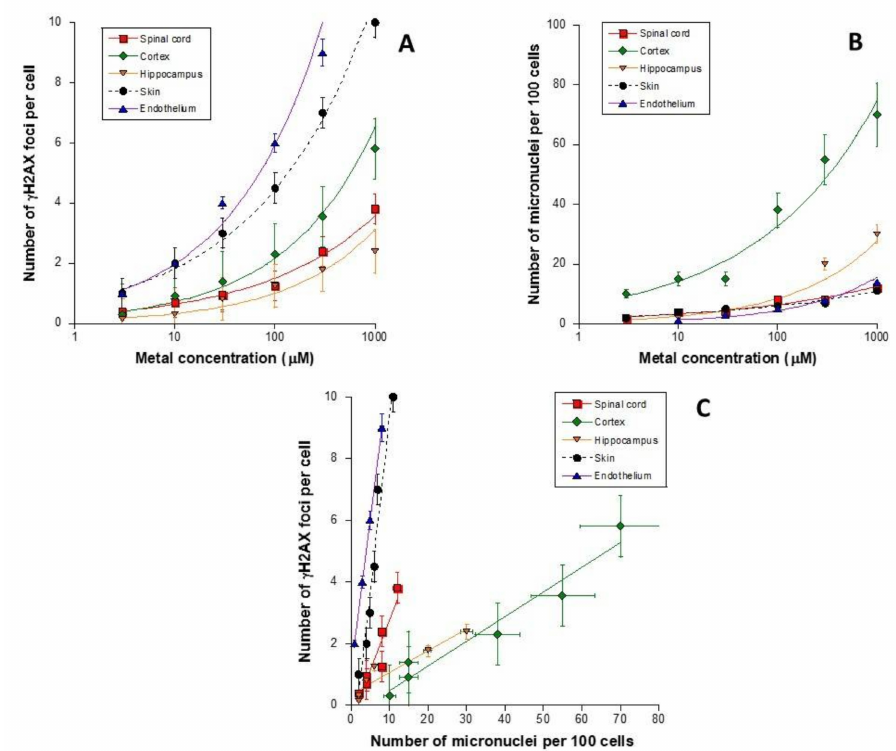
Figure 8. Evidence of a tissue-dependence in the response to metal exposure. ( A , B ). The number of γ H2AX foci per cell ( A ) and micronuclei per 100 cells ( B ) in the human Hasp, Ha, Hah brain cells and the skin fibroblast 149BR cells after incubation for 24 h with the indicated concentration of AlCl 3 . Each plot represents the mean ± standard error (SEM) of at least three replicates. ( C ) The number of γ H2AX foci shown in panel A was plotted against the corresponding number of micronuclei shown in panel B. Solid lines indicate the result of data fitting to a linear